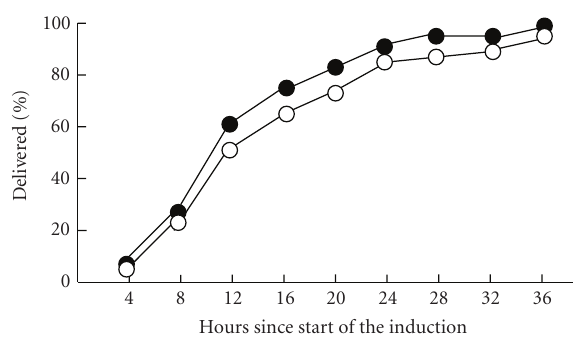
Figure 2: Cumulative delivery rate in women assigned to vaginal misoprostol (closed circles) or intravenous sulprostone (open circles).